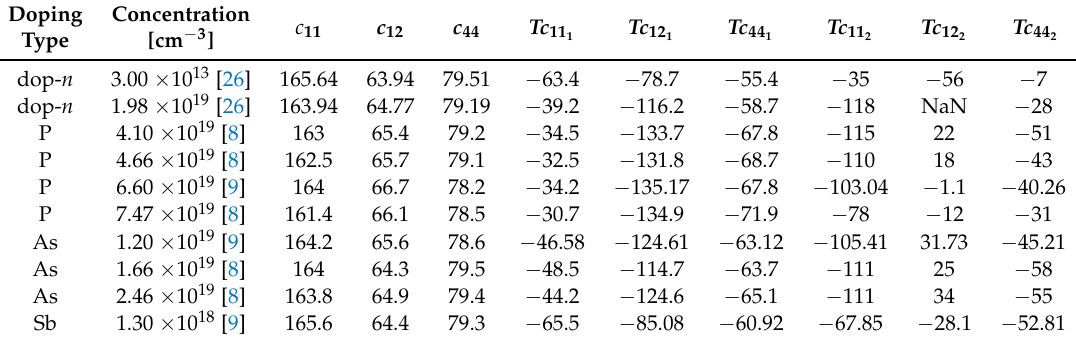
in ppm/ ◦ C and Tc ij in ppb/ ◦ C 2 . 1 2